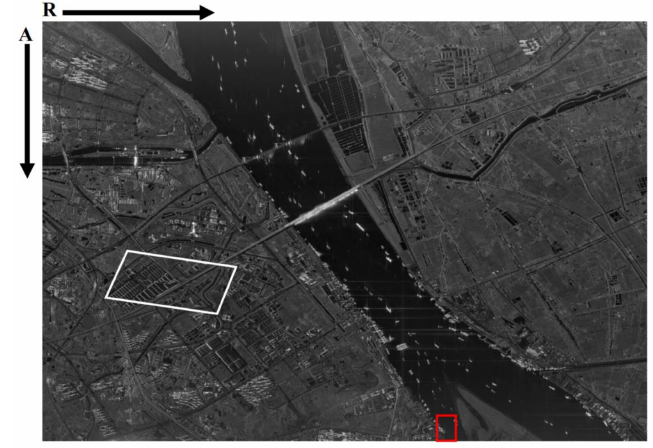
Figure 10. The final product of GF-3 in ST mode.